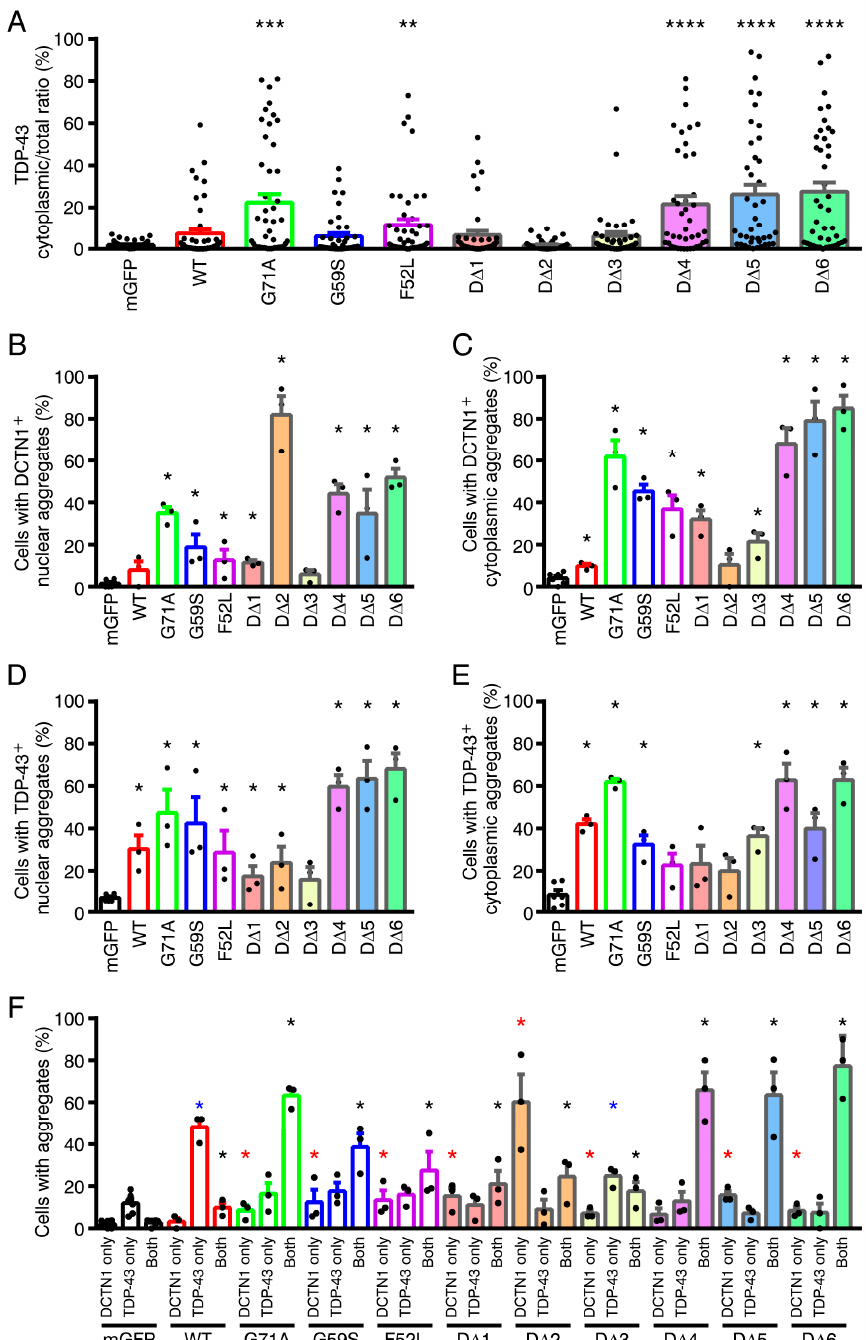
Figure 5. Effects of mutant DCTN1 on TDP-43 localization and aggregation of DCTN1 and TDP-43 in U2OS cells. ( A ) Quantification of cytoplasmic mislocalization of TDP-43. n = 45, 45, 46, 40, 44, 41, 40, 40, 41, 41, and 42 (cells) from left to right (three to four independent experiments). ( B–E ) The percentages of cotransfected cells with DCTN1 ( B , C )- or TDP-43 ( D , E )-positive aggregates in the nucleus ( B , D ) and cytoplasm ( C , E ) are shown. n = 6 (experiments) for the mGFP control group and n = 3 for the other groups (50–60 cells per experimental group). ( F ) Quantification of the existence or coexistence of DCTN1- and/or TDP-43-positive aggregates in individual cells that coexpressed DCTN1-mGFP and mCherry-TDP-43. * p < 0.05; ** p < 0.01; *** p < 0.001; **** p < 0.0001 compared to mGFP and mCherry-TDP-43-coexpressing control cells by two-tailed Mann–Whitney test (in ( F ), red asterisks: comparisons based on aggregates of DCTN1 only; blue: comparisons based on aggregates of TDP-43 only; black: comparisons based on both positive